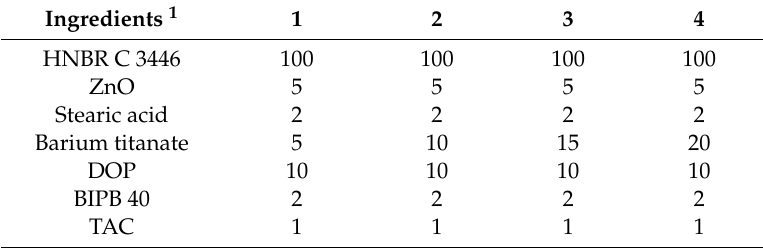
Table 2. Composition of hydrogenated-acrylonitrile butadiene rubber (HNBR) composites with di ff erent filler contents (in